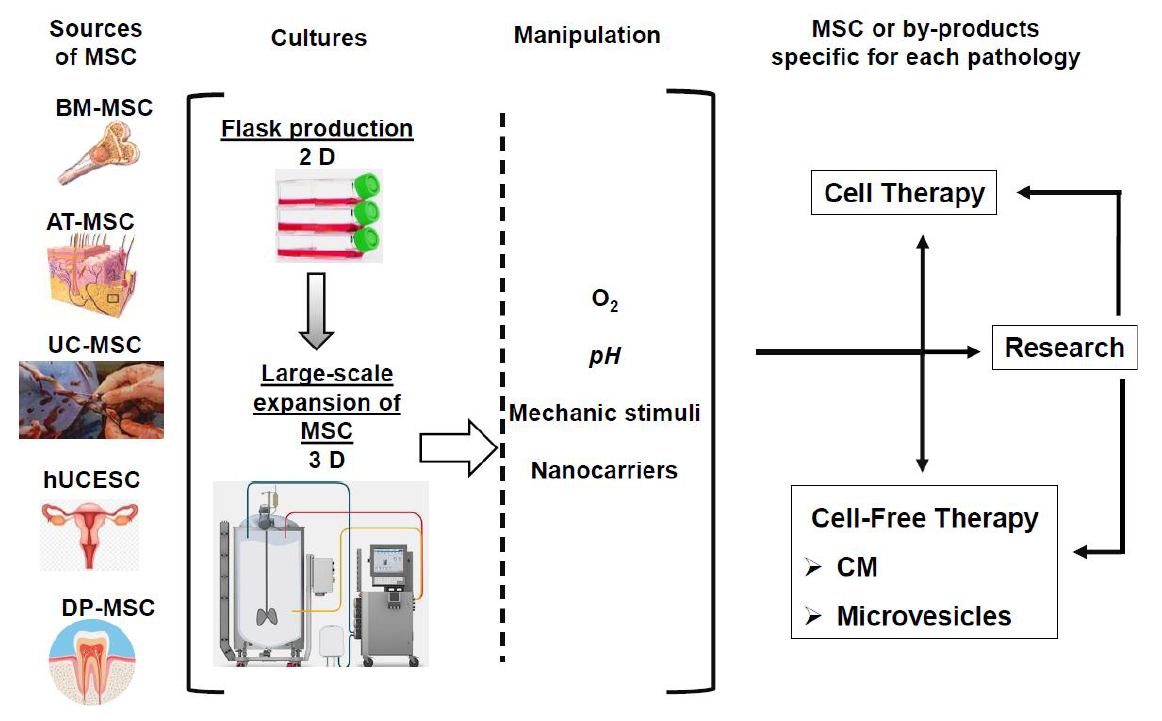
Figure 2. Important concepts for mesenchymal stem cells (MSC) production strategies. It is necessary to consider, for each application, tissue origin of MSC, system employed for in vitro expansion, and the final product for the therapy.